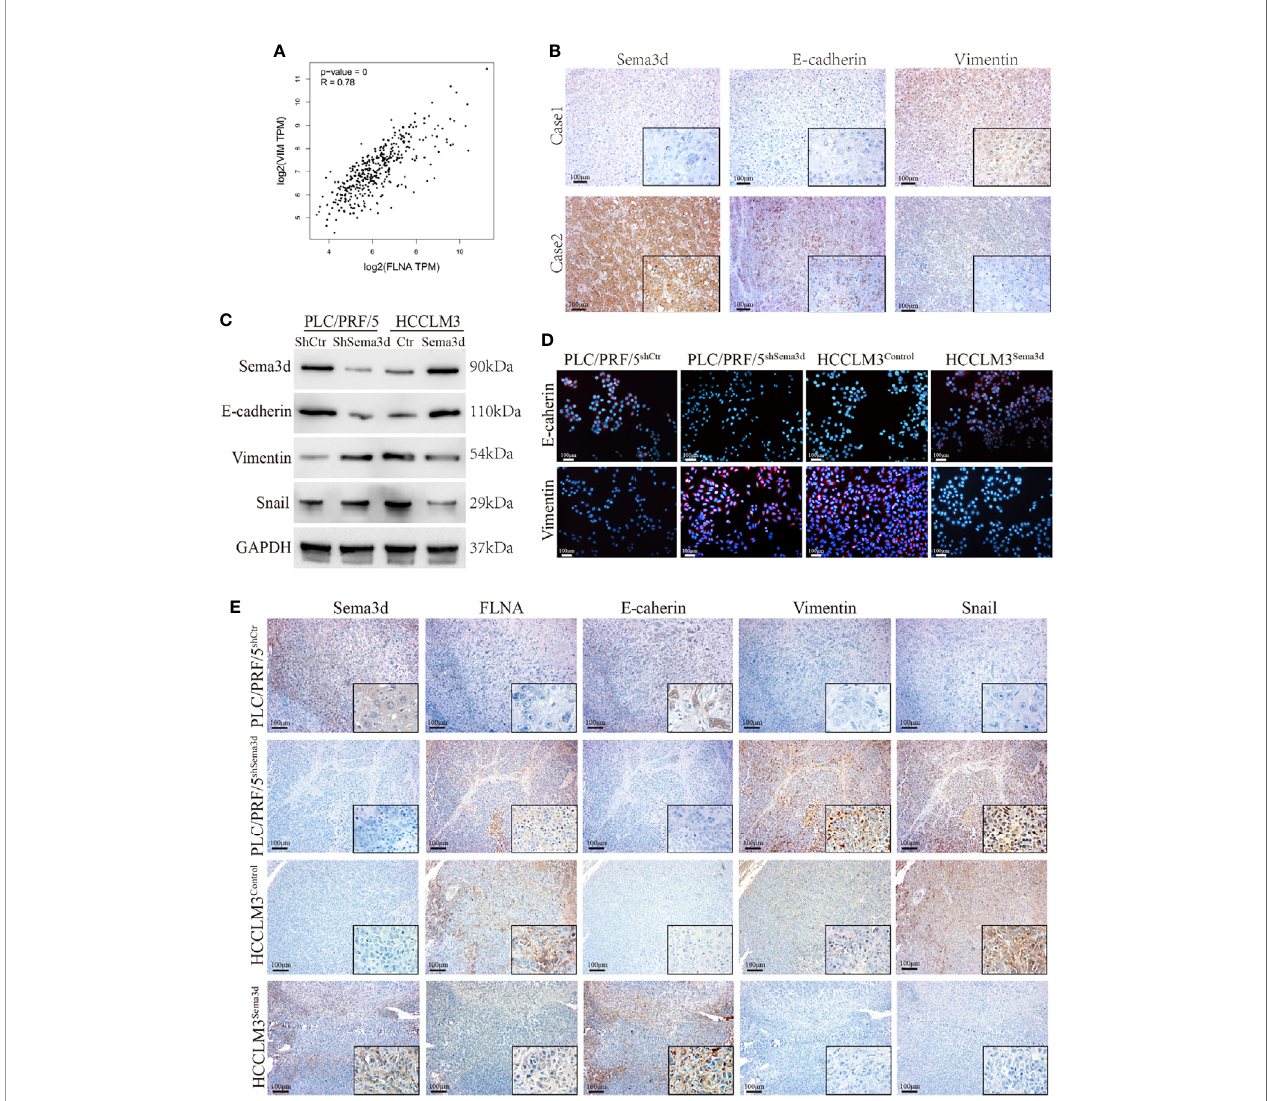
FIGURE 6 | Downregulation of Sema3d promotes EMT in HCC. (A) Correlation of FLNA and vimentin mRNA expression levels was analyzed from TCGA. (B) Representative image of Sema3d, E-cadherin, and vimentin expression level in HCC tissue detected by IHC. (C) EMT marker proteins in PLC/PRF/5 shSema3d and HCCLM3 Sema3d cells and their corresponding control cells were detected by Western blot. (D) EMT marker proteins in Sema3d-interfered PLC/PRF/5 and HCCLM3 cells detected by IF. (E) IHC was performed to detect the FLNA and EMT marker proteins in consecutive sections of a liver orthotopic xenograft tumor derived from Sema3d-interfered PLC/PRF/5 and HCCLM3